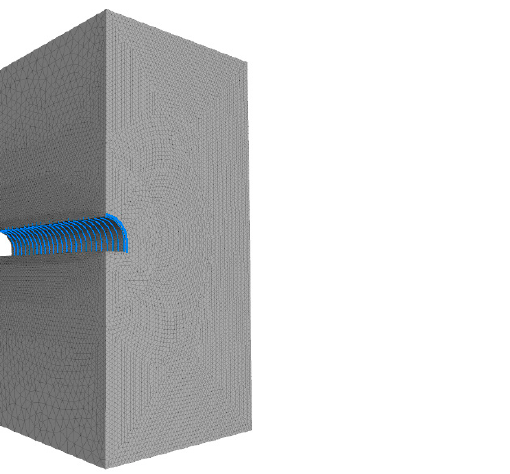
Figure 5. Numerical model adopted for the calculations with structural elements representing the steel arch